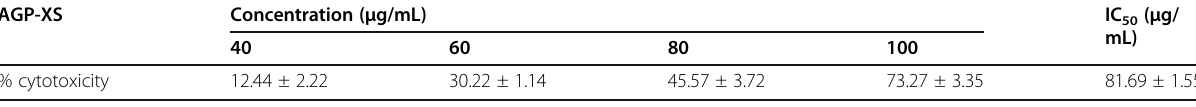
All values are reported as means ± SEM ( n